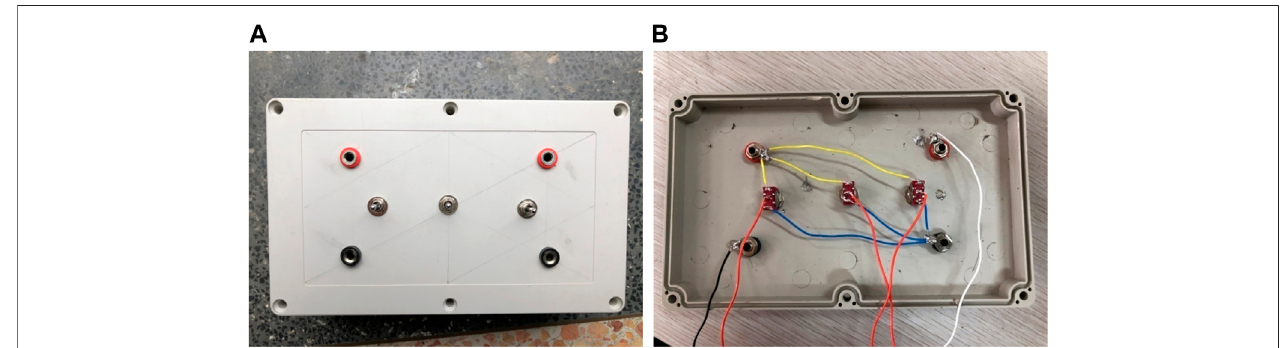
FIGURE 4 | Switch box. (A) Surface of the switch box. (B) Inside of the switch box.